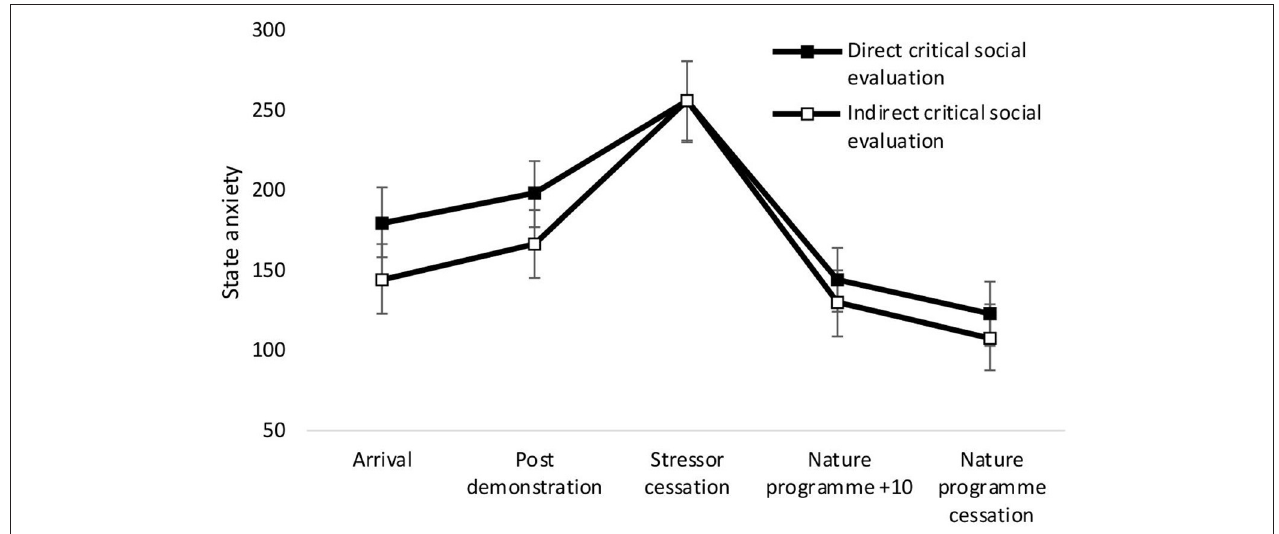
FIGURE 2 | Mean (and SE) state anxiety for the direct social evaluation and indirect social evaluation conditions, assessed during exposure to the stressor manipulation.